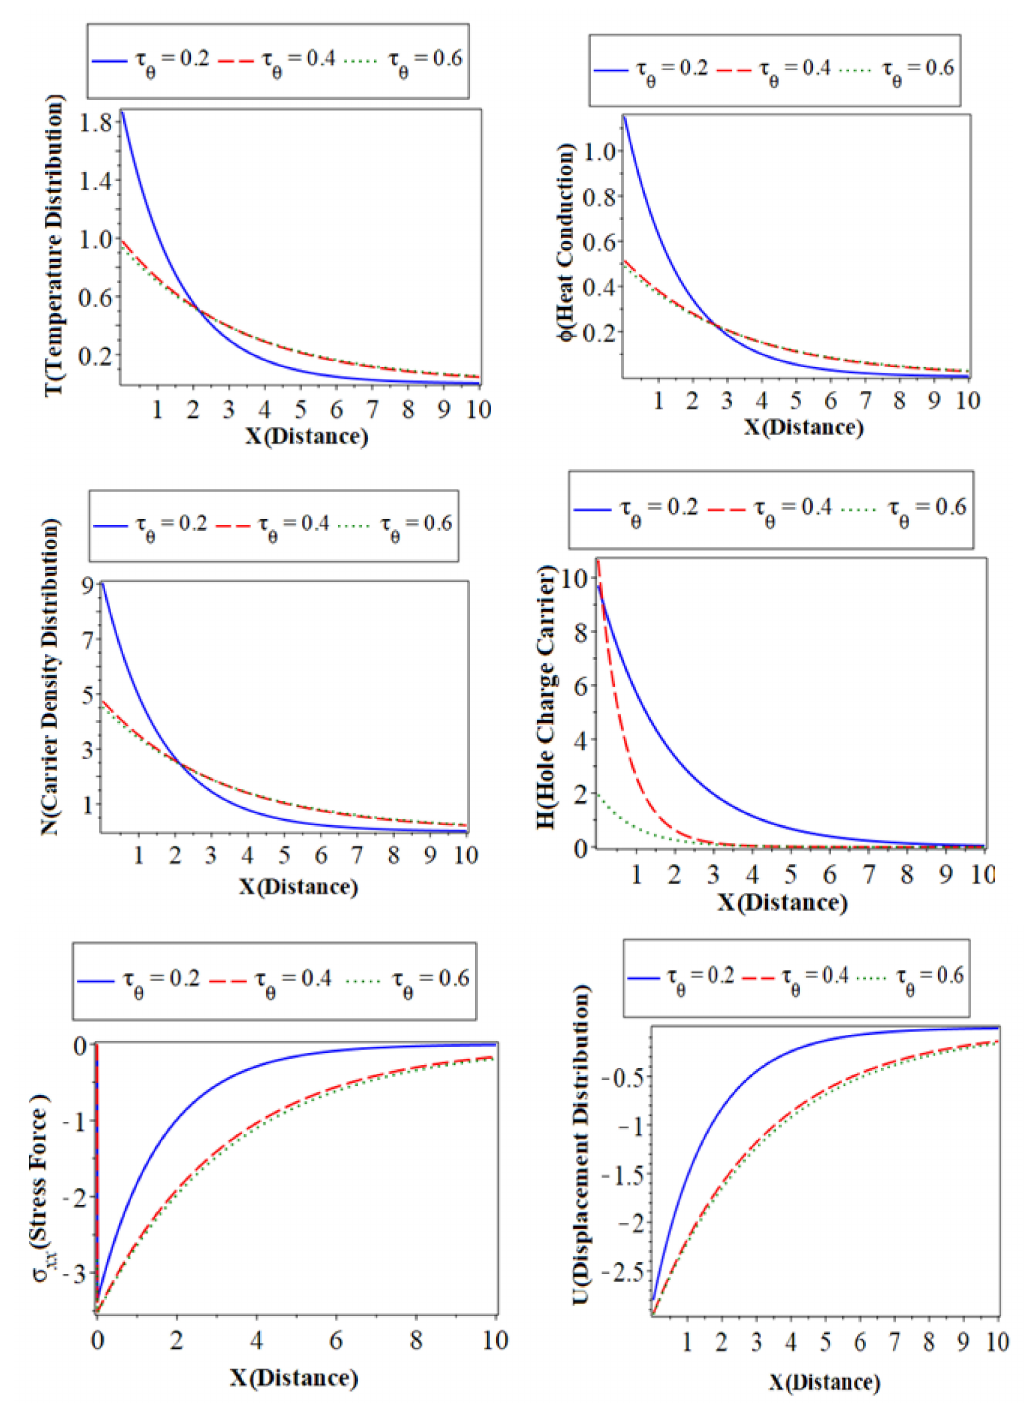
Figure 2. The variation of physical field distributions with distance at different values; the phase-lag of the temperature gradient τ θ when ε 1 = 0.001 and τ q =